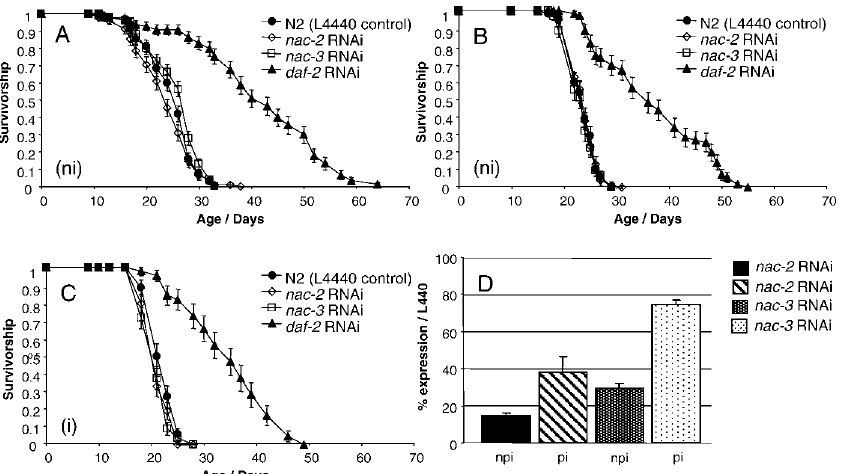
Figure 7. Effects on Lifespan in C. elegans of RNAi of nac-2 , nac-3, and daf-2 (22 8 C) Lifespan analysis of the mutants subjected to bacteria-mediated RNAi in nonpreinduced and preinduced conditions (see text for details). N2 (wild-type) worms fed with L440 plasmid was used as a vector control. Three independent replicates of the experiments are shown. Log-Rank test v 2 and p- values: A) L4440 versus nac-2 ( v 2 ¼ 1.82, p ¼ 0.1772), L4440 versus nac-3 ( v 2 ¼ 4.01, p ¼ 0.0452), and L4440 versus daf-2 ( v 2 ¼ 137.99, p , 0.0001). B) L4440 versus nac-2 ( v 2 ¼ 1.02, p ¼ 0.8923), L4440 versus nac-3 ( v 2 ¼ 0.52, p ¼ 0.4727), and L4440 versus daf-2 ( v 2 ¼ 39.11, p , 0.0001). C) L4440 versus nac-2 ( v 2 ¼ 3.82, p ¼ 0.0507), L4440 versus nac-3 ( v 2 ¼ 5.09, p ¼ 0.024), and L4440 versus daf-2 ( v 2 ¼ 65.76, p , 0.0001). D) The efficiency of the RNAi of nac-2 and nac-3 by the two methods of induction used for lifespan experiments (RT-PCR). On average, nac-2